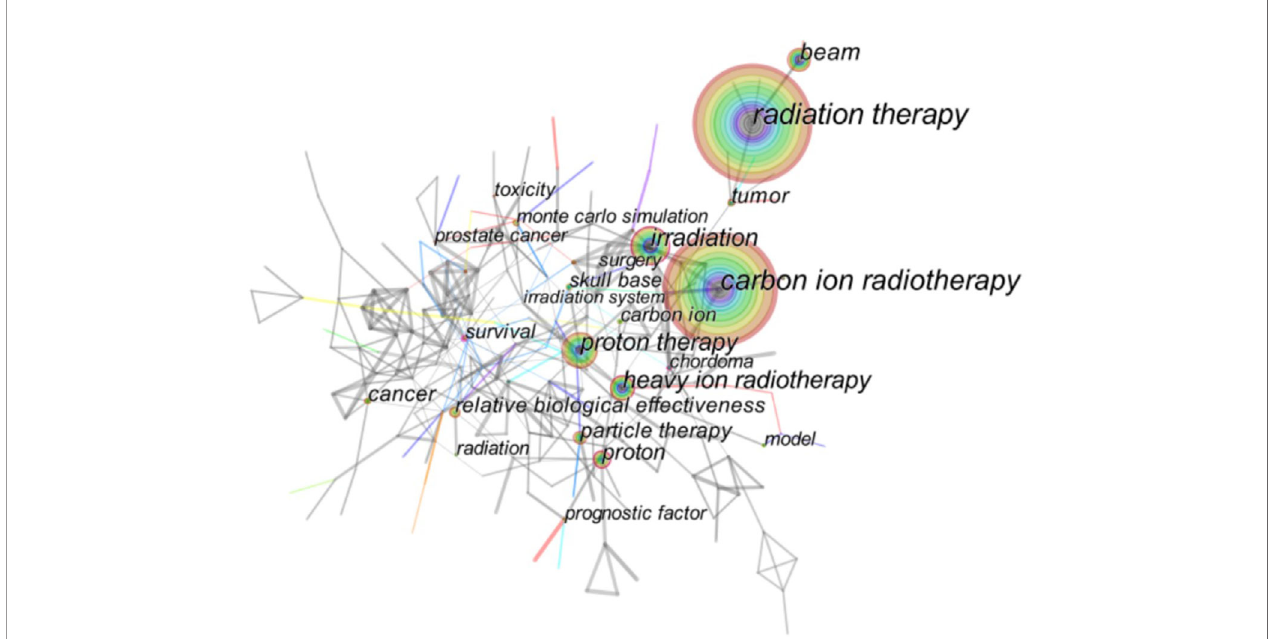
FIGURE 4 | Co-ocurrence analysis of keywords related to HIRT